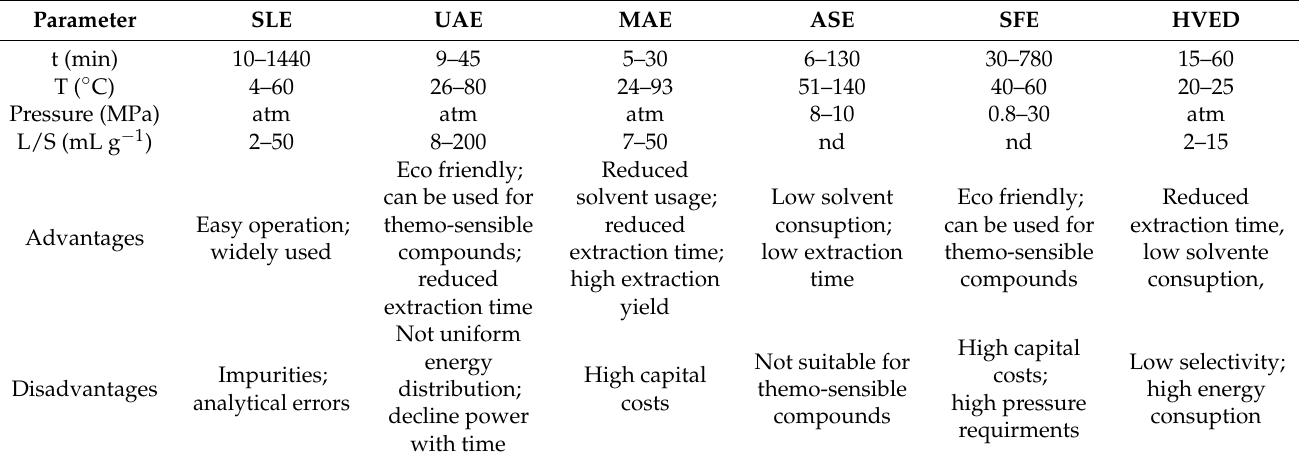
Table 12. Operational parameters, advantages and disadvantages [122] of each extraction